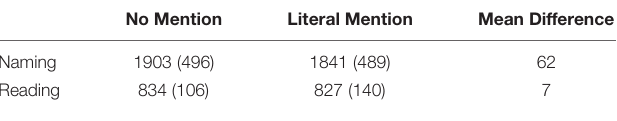
TABLE 1 | Mean response latencies in ms (and standard deviation) per condition in Naming (Experiment 1), in Reading (Experiment 2), and the mean difference across conditions (No Mention – Literal